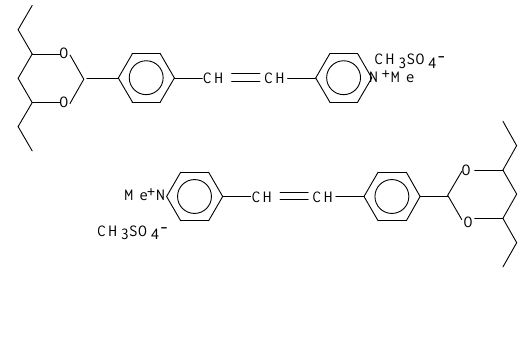
Figure 1. PVA-SbQ photocrosslinkable